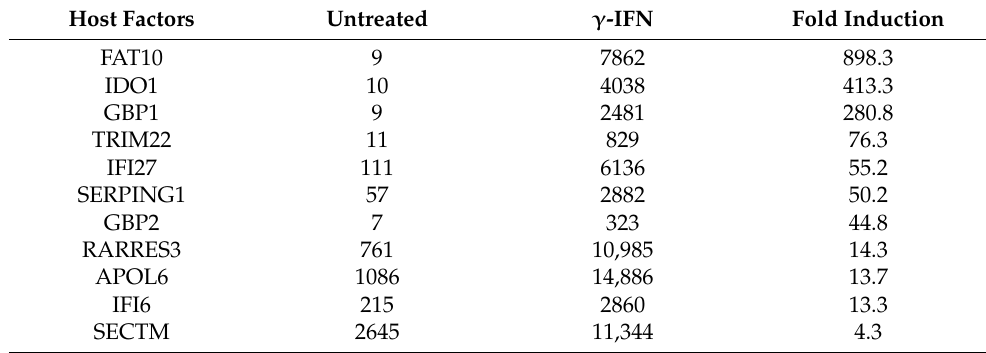
Table 2. Fold induction of γ -IFN-induced factors by γ